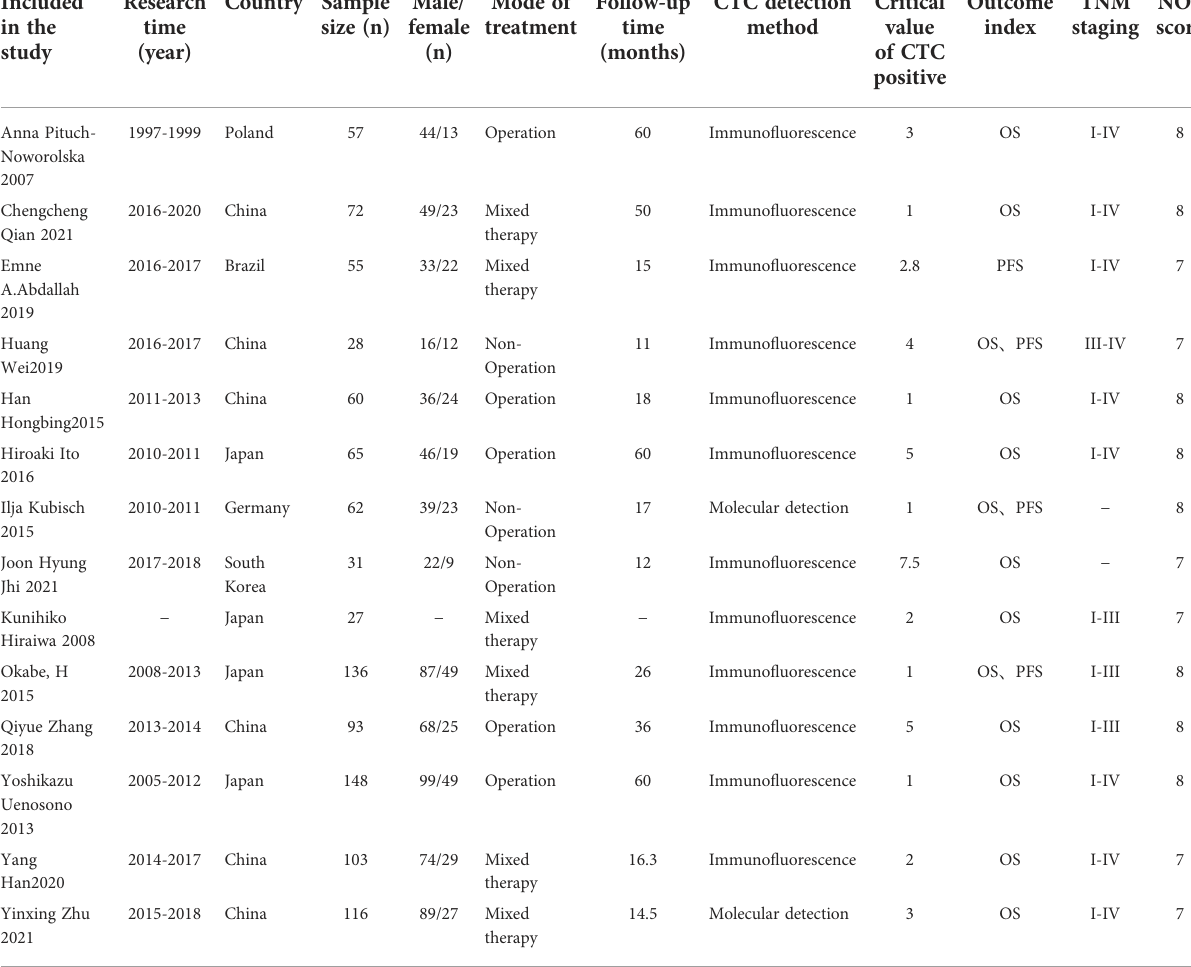
TABLE 1 Basic characteristics of the included study. Included in the